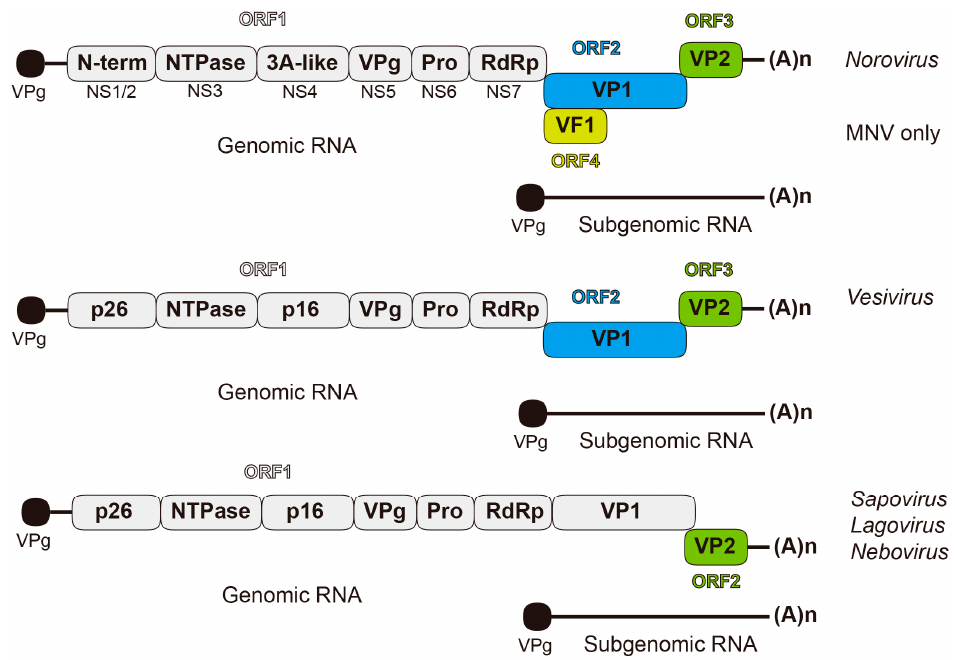
Figure 1. Diagrammatic representation of open-reading frame (ORF) usage in the different Caliciviridae genomic and subgenomic RNA. Protein VPg present at 5’-ends of both the genomic and subgenomic RNAs is depicted by a black circle at the end of a line representing the viral RNA. The full-length genome is organized into 2–4 ORFs. A subgenomic RNA consisting of ORF2 and ORF3 is also produced during replication. ORF1 encodes a polyprotein, processed into individual non-structural proteins, while ORF2 and ORF3 code for the structural capsid proteins VP1 and VP2, respectively. In addition to these core proteins, MNV ORF4 encodes VF1, and the FCV (Vesivirus) encodes a leader capsid (LC).